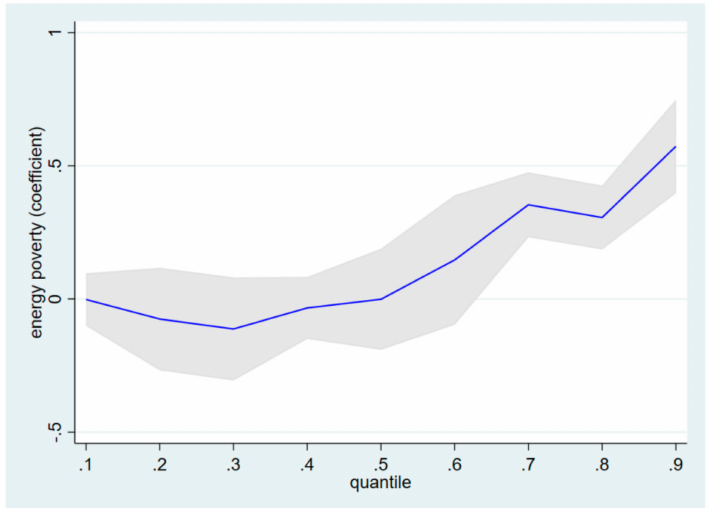
Figure 3. Instrumental variable quantile regression estimates for the impact of energy poverty (EP1) on depression. Notes: The x -axis denotes the nine conditional quantiles of the CES-D8 depression scores, and the y -axis presents the coefficient estimates of energy poverty measure (EP1). Shaded areas correspond to 95% confidence intervals of quantile